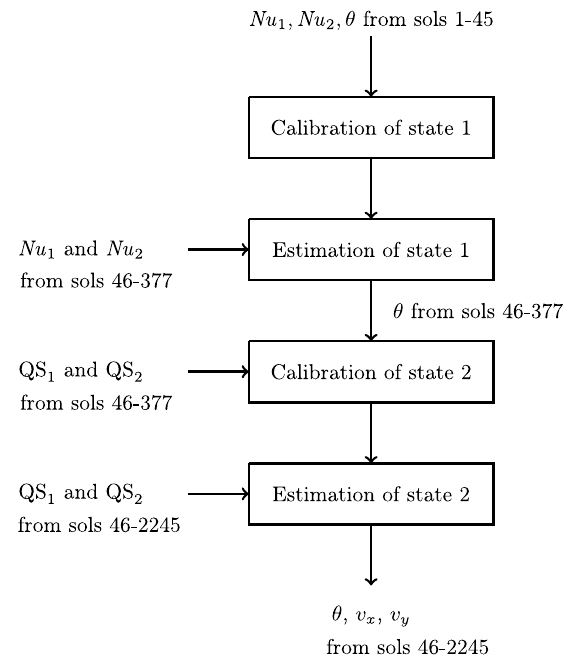
Figure 5. Schema of the complete processing chain of the wind reconstruction algorithm. Nu 1 and Nu 2 are the Nusselt numbers of wind sensors 1 and 2, QS 1 and QS 2 are the voltage values of the thermocouple pairs, θ is the wind direction, and v x and v y are the wind speed normal